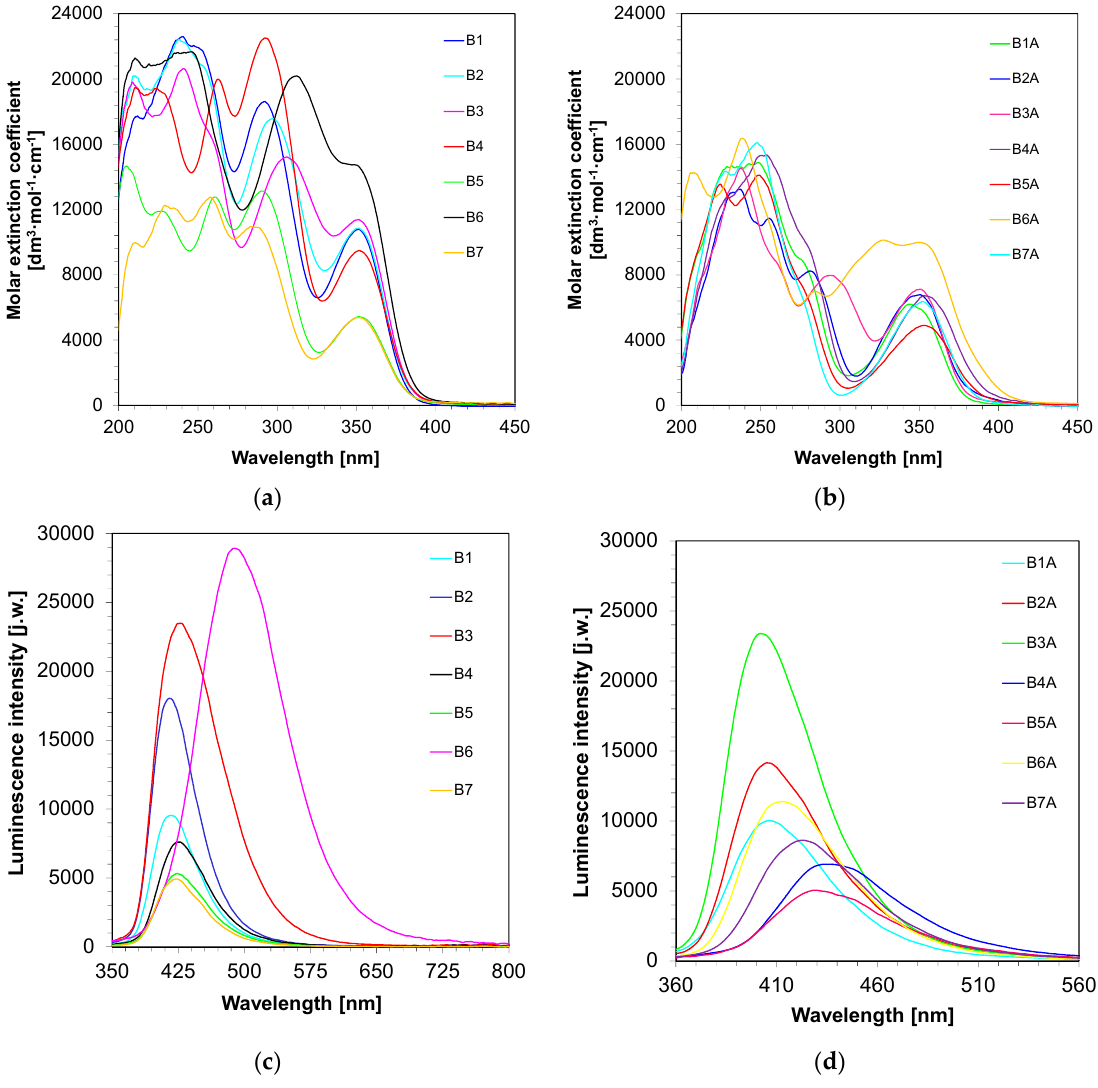
Figure 1. Spectroscopic properties of the 2-amino-4-methyl-6-phenyl-benzene-1,3-dicarbonitrile derivatives. ( a ) UV-visible absorption spectra of series 1 in acetonitrile; ( b ) UV-visible absorption spectra of series 2 in acetonitrile; ( c ) fluorescence spectra of series 1 in acetonitrile in extinction 320 nm and integration time 1s; ( d ) fluorescence spectra of series 2 in acetonitrile in extinction 320 nm and integration time 1 s.